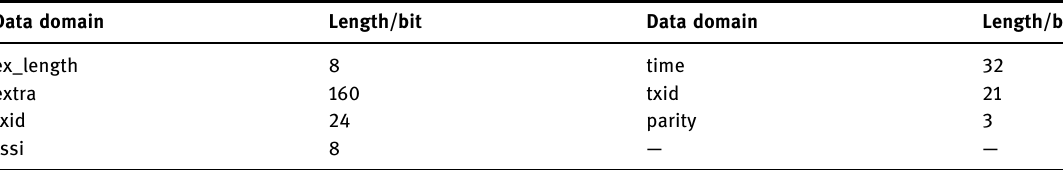
Table 4: Multifunction sensor data